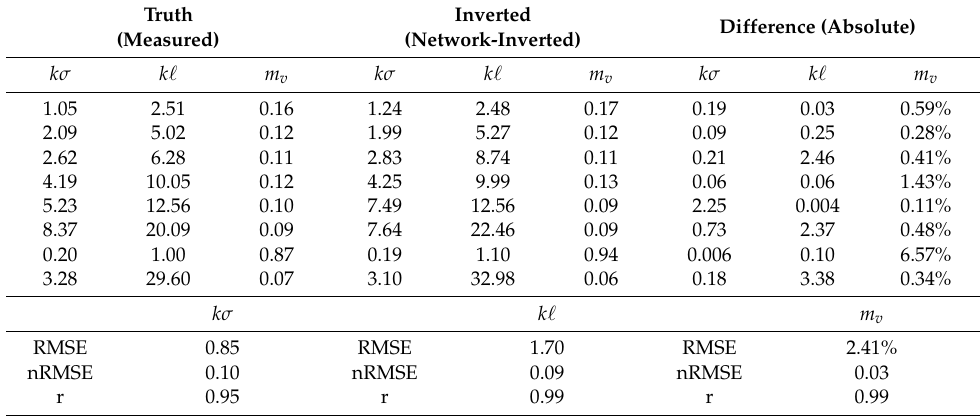
Table 6. Comparison of surface parameters between measured and inverted by model-trained DLNN. Truth Inverted Difference (Measured) (Network-Inverted)